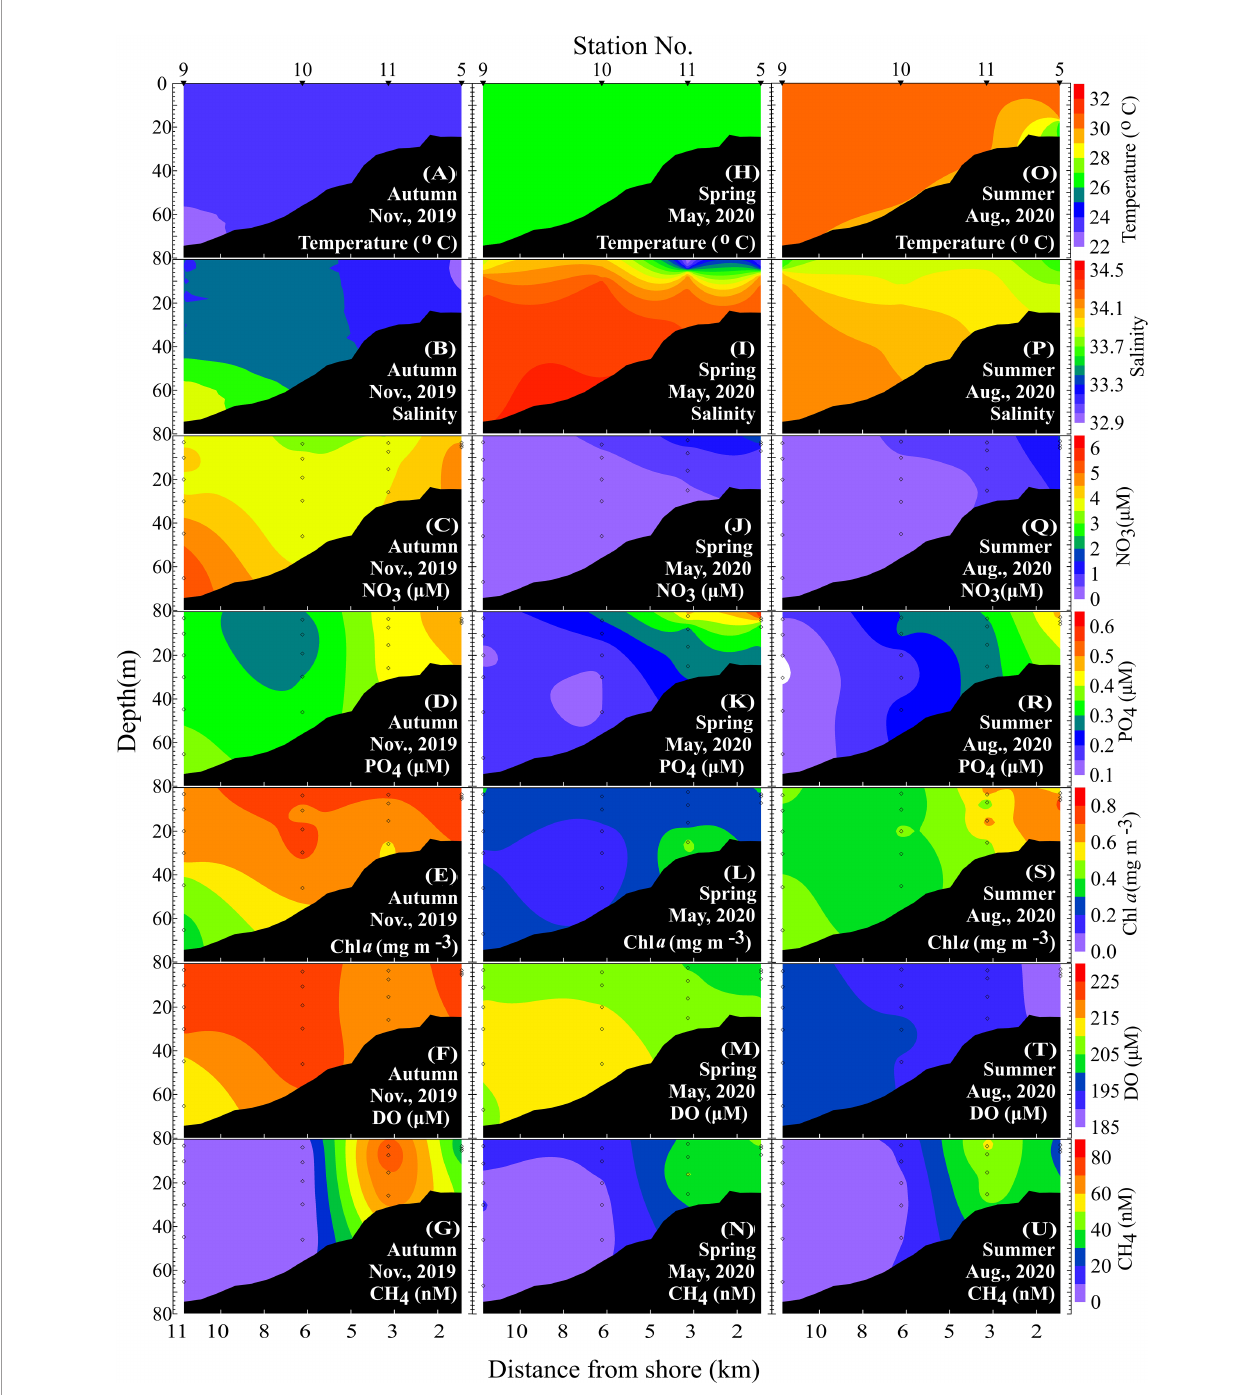
FIGURE 2 | Cross-section of temperature, salinity, NO 3 , PO 4 , Chl a , DO and CH 4 (A – G) in autumn, (H – N) in spring, and (O – U) in